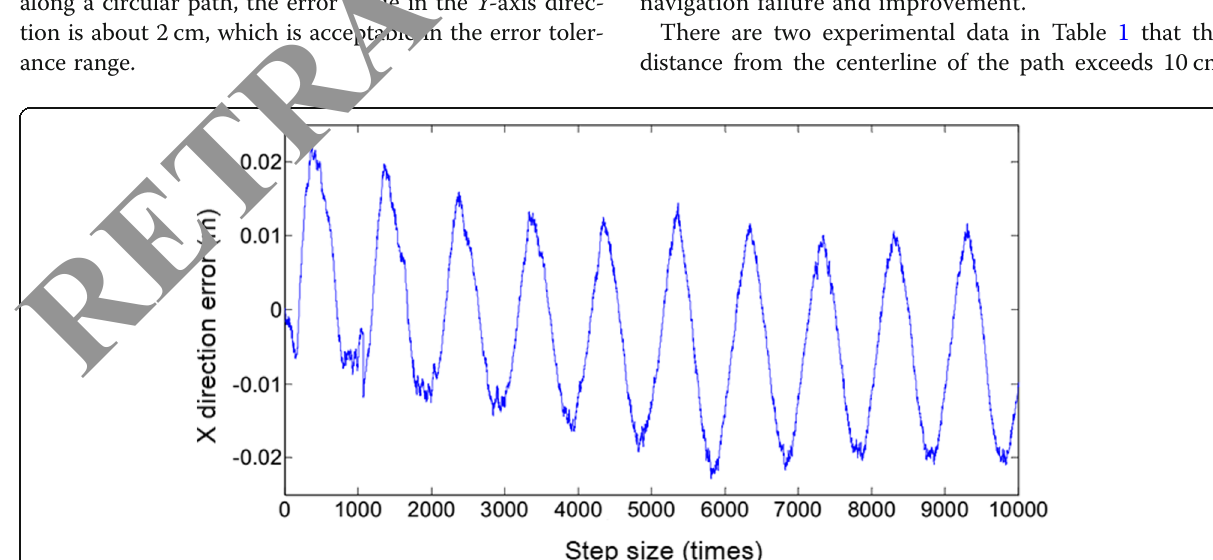
Fig. 8 Error analysis in the X direction